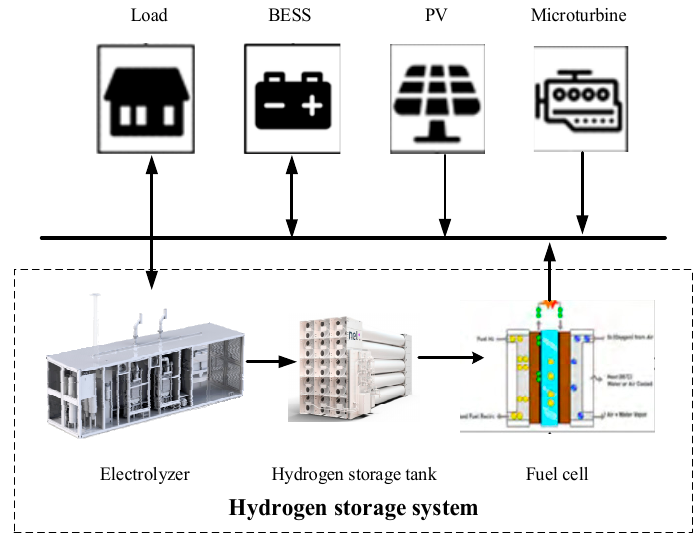
Figure 1. Schematic diagram of the microgrid.